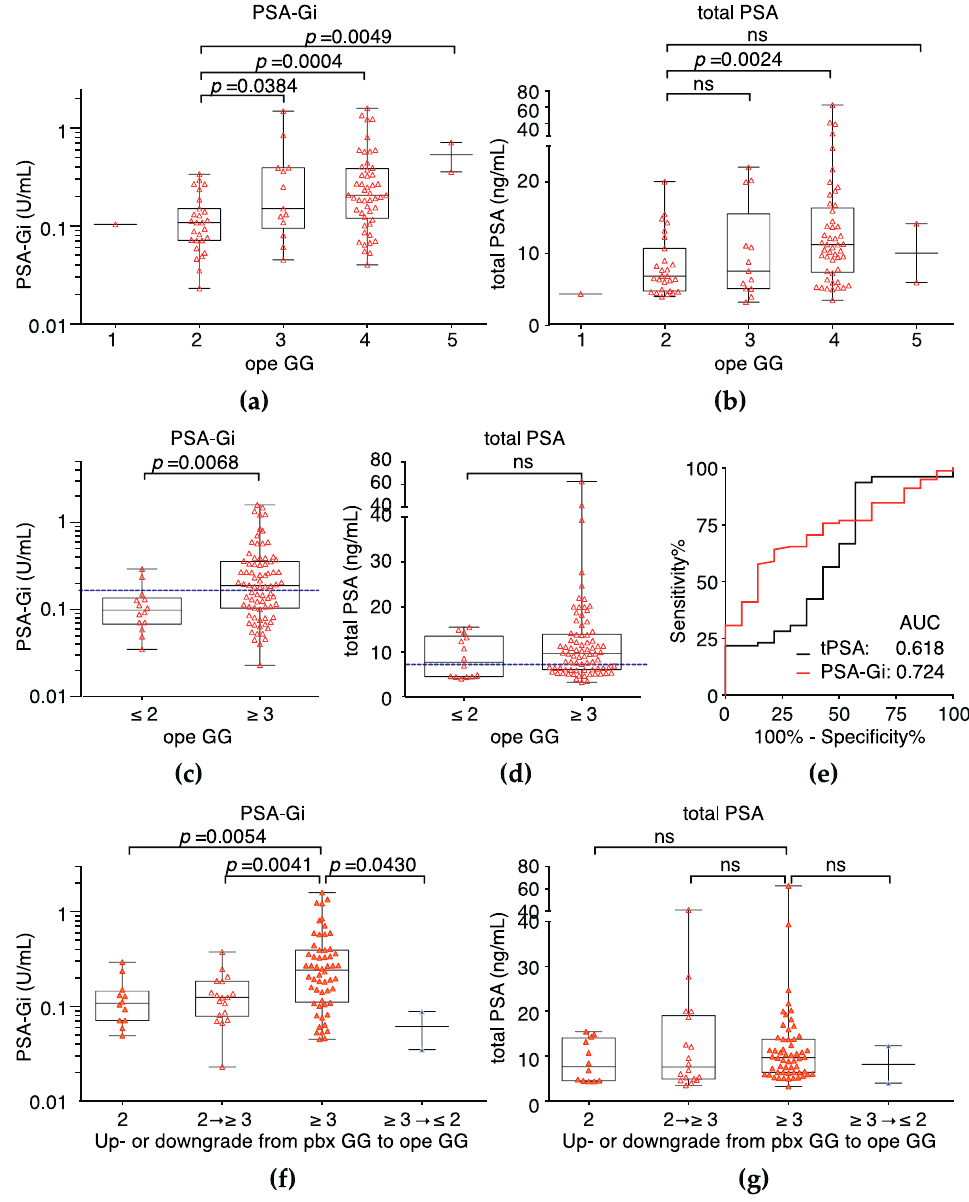
Figure 5. The serum PSA-Gi levels at Pbx in PCa patients who underwent RP. ( a ) PSA-Gi levels before Pbx among PCa patients classified by the grade group after RP (ope GG); ( b ) total PSA level before Pbx of PCa patients classified by the ope GG; ( c , d ) PSA-Gi and total PSA levels before Pbx between patients with ope GG ≤ 2 and ope GG ≥ 3. Cutoff levels at 60% sensitivity of PSA-Gi and/or total PSA is presented as a blue dotted line; ( e ) ROC curve analysis of total PSA and PSA-Gi in PCa patients with ope GG ≤ 2 and ope GG ≥ 3. The AUCs for the prediction of patients with ope GG ≥ 3 of PSA-Gi and total PSA were 0.724 and 0.618, respectively; ( f , g ) PSA-Gi and total PSA levels in patients with a GG upgrade from 2 at Pbx to ope GG ≥ 3 and a GG downgrade from ≥ 3 at Pbx to ope GG ≤ 2.4. Tumors Strongly and Moderately Positive for WFA Is an Independent Risk Factor of PSA Recurrence